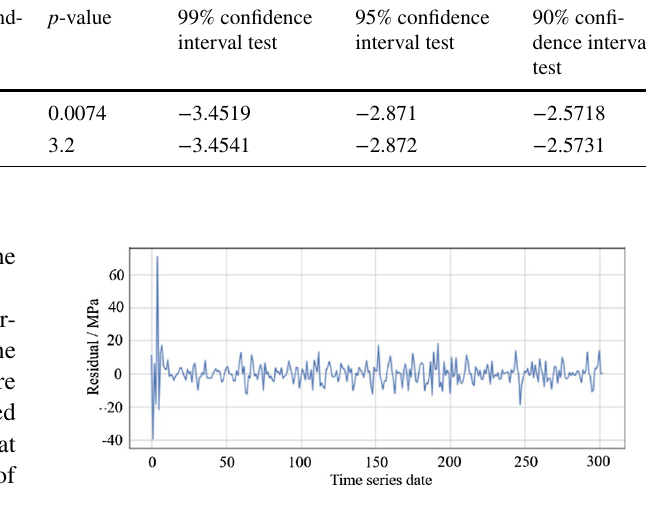
Fig. 10 Residual values of the model